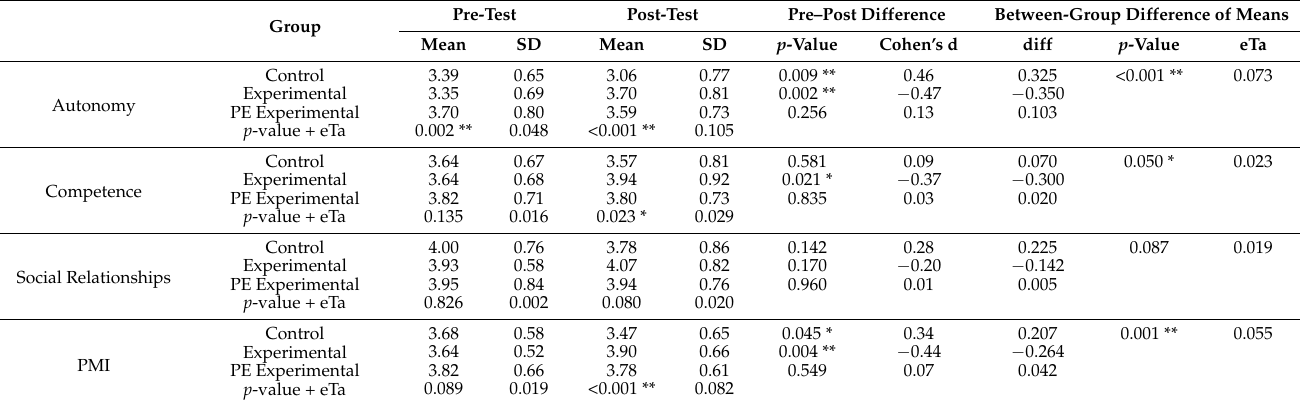
Table 4. Self-determination theory results (psychological basic needs).